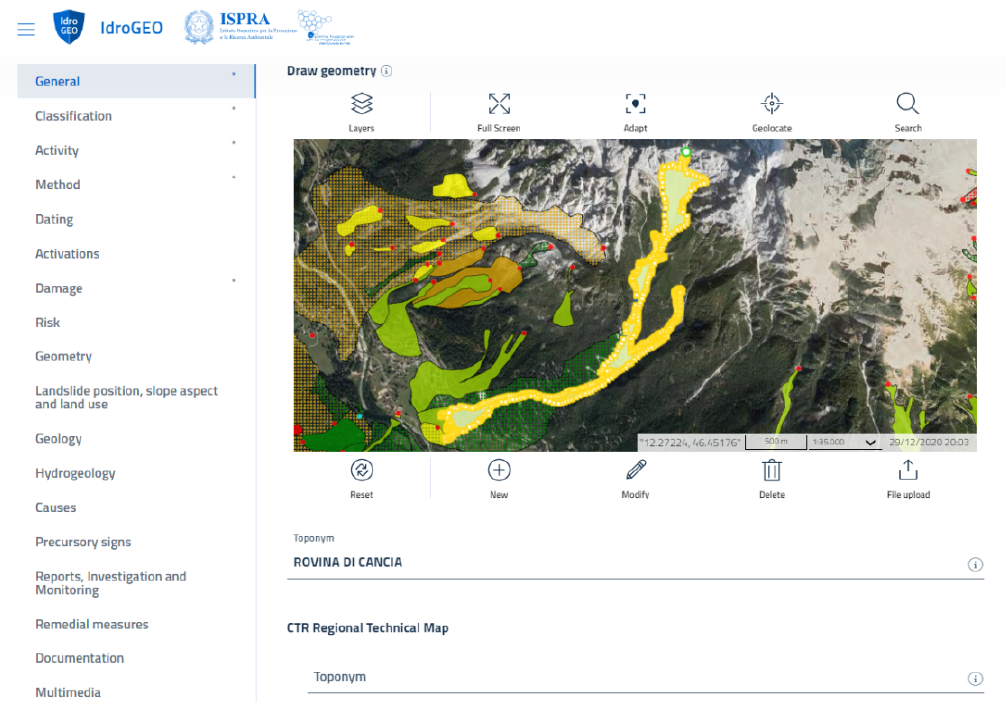
Figure 5. IdroGEO platform—IFFI web editor.